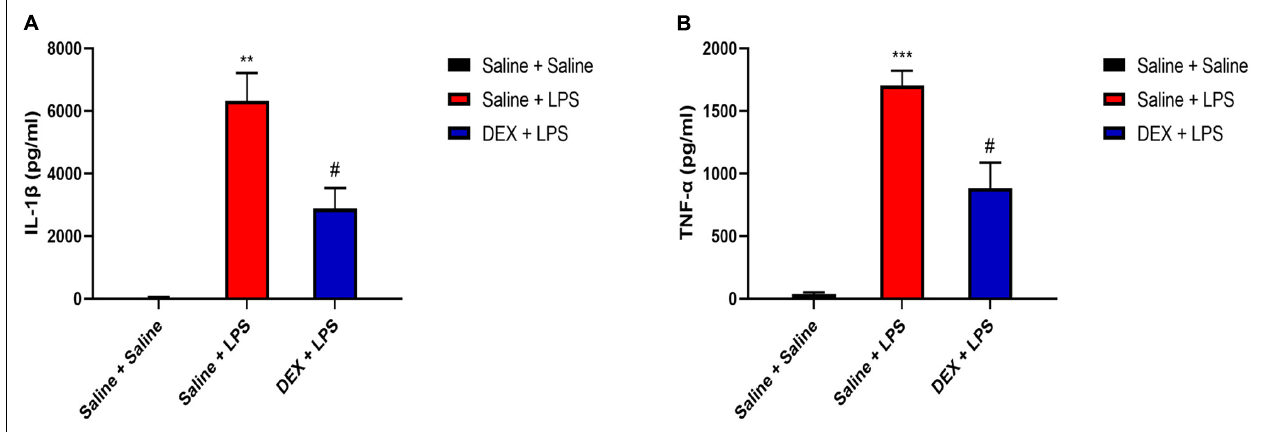
FIGURE 5 | Dexmedetomidine (DEX) pretreatment attenuated systemic LPS-induced peripheral inflammation. (A) LPS induced an increased level of IL-1 β in serum. DEX pretreatment decreased LPS-induced upregulation of IL-1 β . (B) LPS induced an increased level of TNF- α in serum. DEX pretreatment decreased LPS-induced upregulation of TNF- α . Results are expressed as the mean ± SEM, n = 4–5 animals for each group, and were analyzed by Brown–Forsythe and Welch ANOVA tests followed by Tamhane’s T2 multiple comparisons test. ** P < 0.01, *** P < 0.001 Saline + LPS group vs. Saline + Saline group. # P < 0.05 DEX + LPS group vs. Saline + LPS